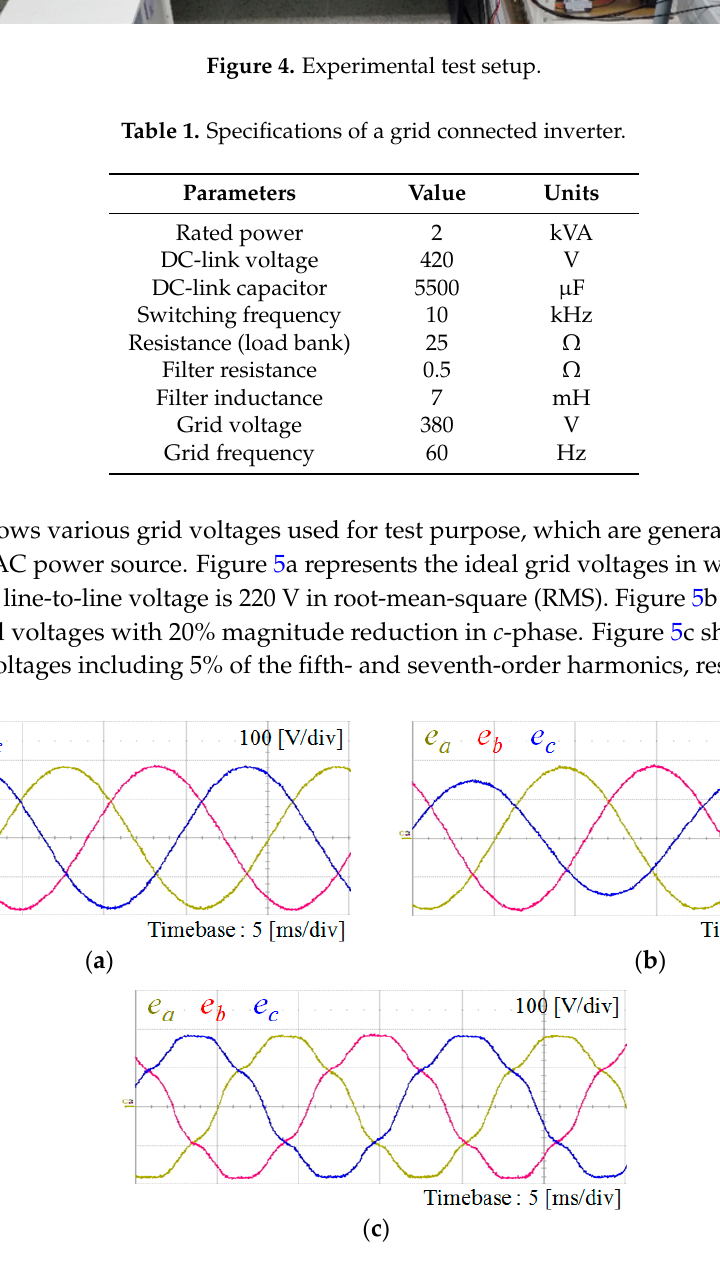
Figure 5. Grid voltages under various conditions. ( a ) Ideal grid voltages; ( b ) three-phase unbalanced grid voltages; and ( c ) harmonic distorted grid voltages.